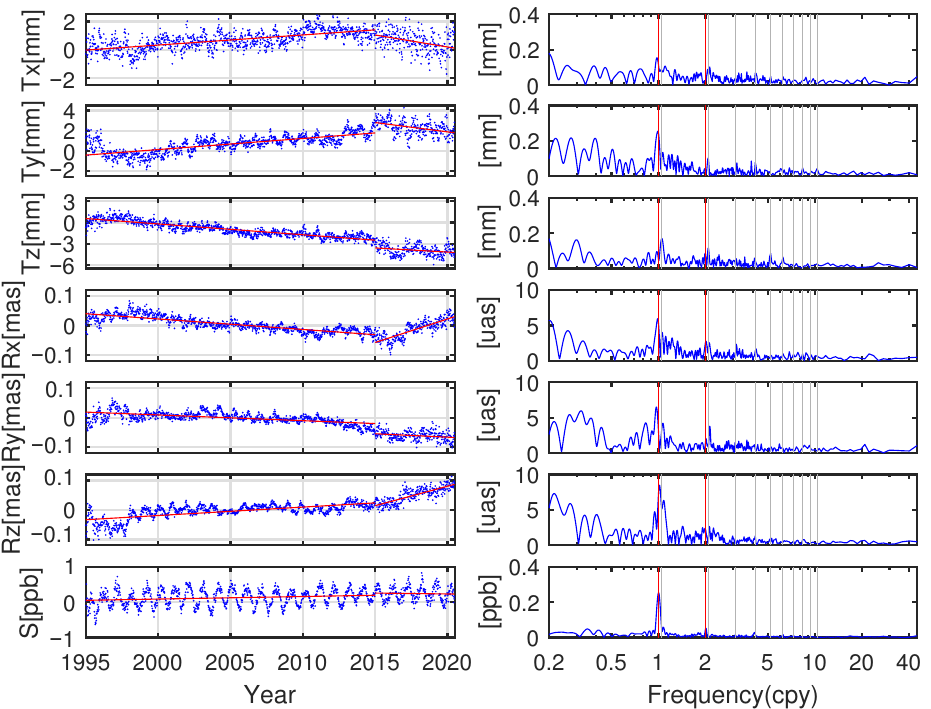
Figure 7. Time series of the translation, rotation, and scale offsets estimated between DTRF2014 and IGS and their amplitude spectra from top to bottom (blue). The linear trend curve before and after 2015.0 of the Helmert parameters are also plotted (red lines). The vertical gray lines indicate the first 10 harmonics of the GPS draconitic year, and the two vertical red lines indicate the annual and semiannual